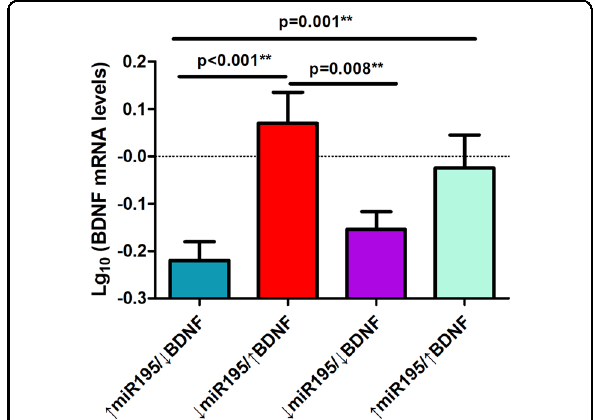
Fig. 3 mRNA BDNF level based on median split of miR195 and BDNF protein. Patients with ↓ miR195/ ↑ BDNF had signi fi cantly higher BDNF mRNA levels compared to patients with ↑ miR195/ ↓ BDNF and ↓ miR195/ ↓ BDNF.